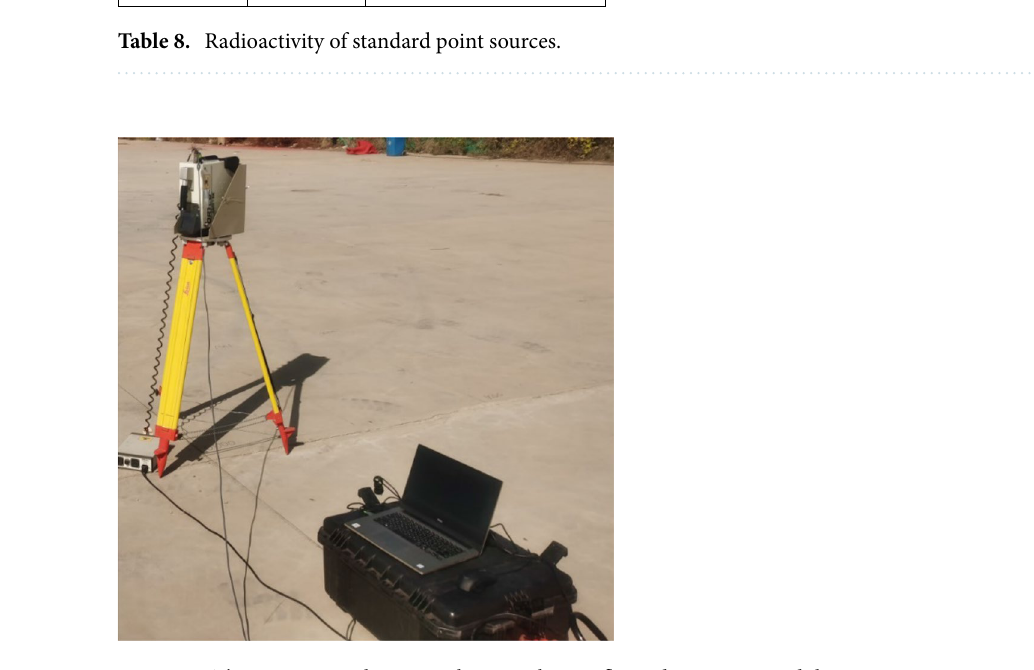
Figure 7. The experimental site was chosen to be in a flat and open area, and the HPGe γ spectrometer was set up at the height of 1 m from the ground and connected to a computer. Place the radioactive sources in sequence according to the grid division method described in Fig. 6 to complete the